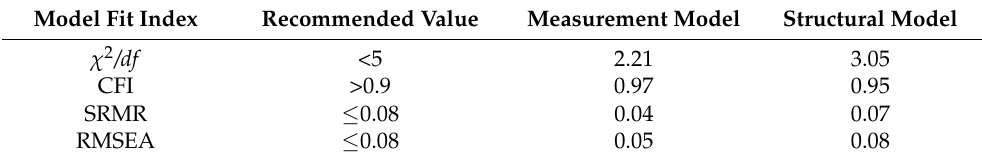
Table 3. Model fit indices for the measurement model and structural